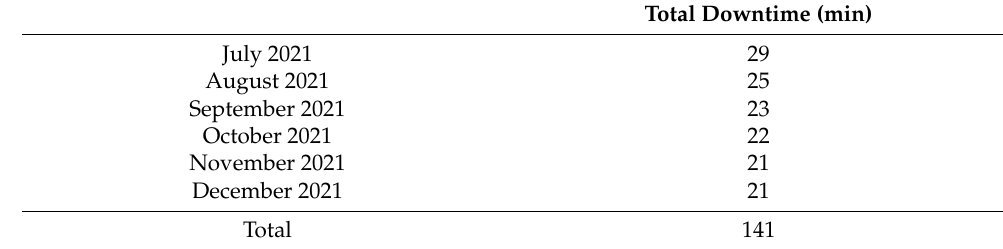
Table 3. Downtimes after using DT.